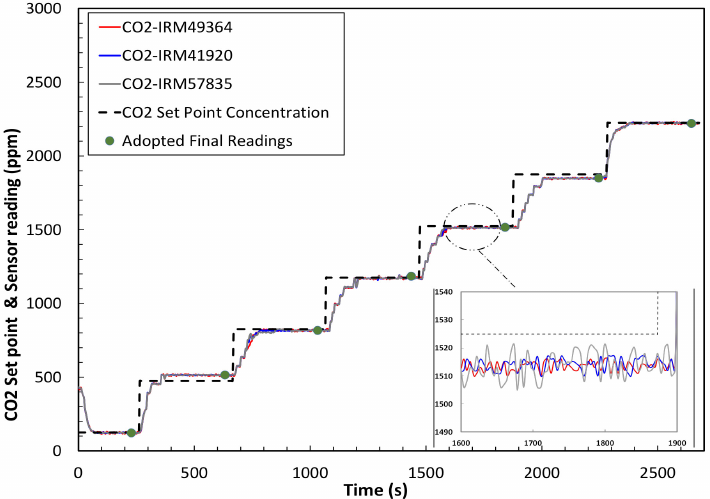
Figure 16. CO 2 set points and sensors’ detected CO 2 concentration after calibration (ppm).